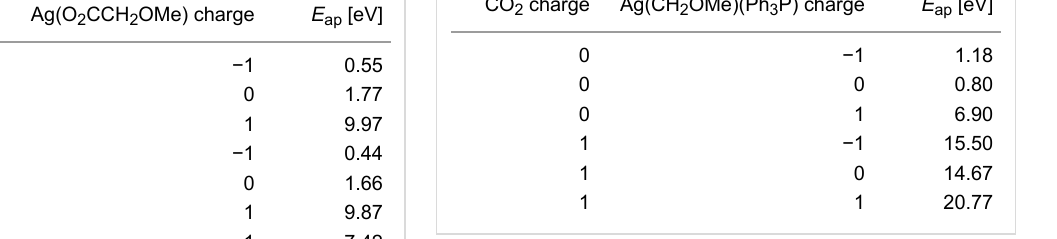
Table 3: Appearance energy (Equation 2) of differently charged Ph 3 P and [AgO 2 CCH 2 OMe] fragments from dissociation of monomeric 2 . Ph 3 P charge